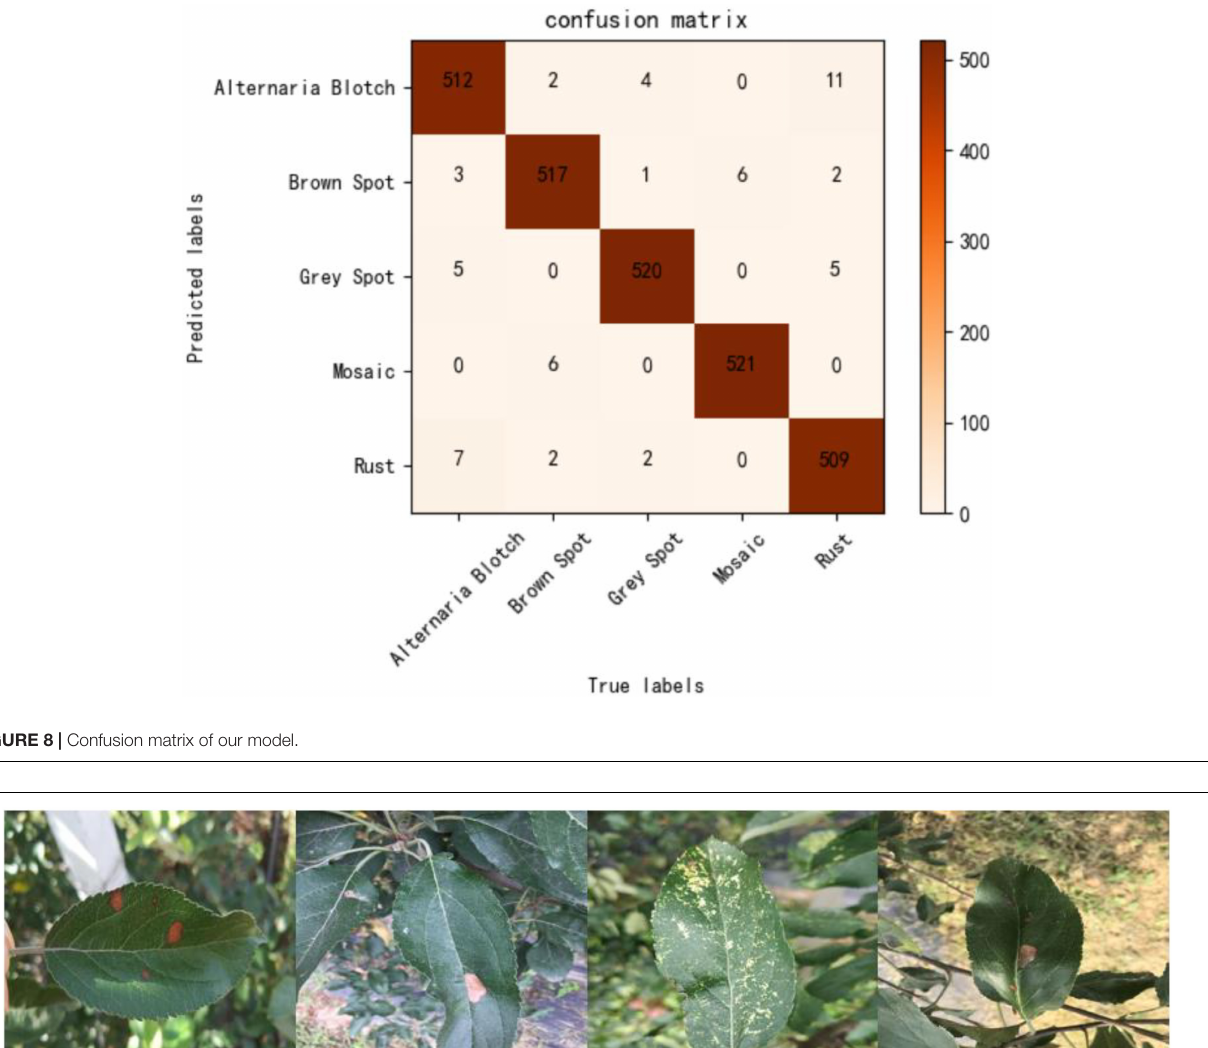
FIGURE 8 | Confusion matrix of our model.